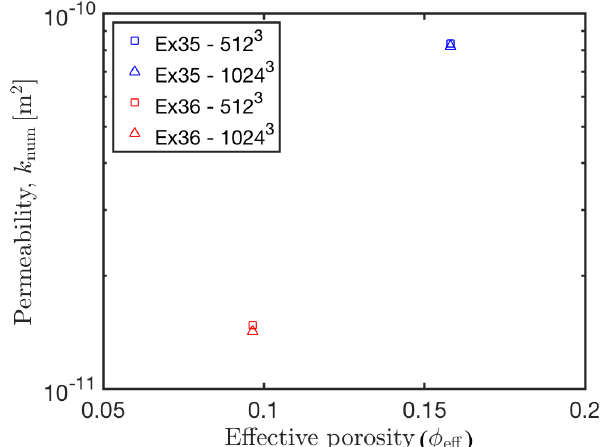
Figure F1. Resolution test using samples Ex35Sub04 and Ex36Sub02 (for details, see also tables in the Supplement). Coloured squares denote a standard resolution of 512 3 , whereas coloured triangles are simulations with a resolution of 1024 3 vox-